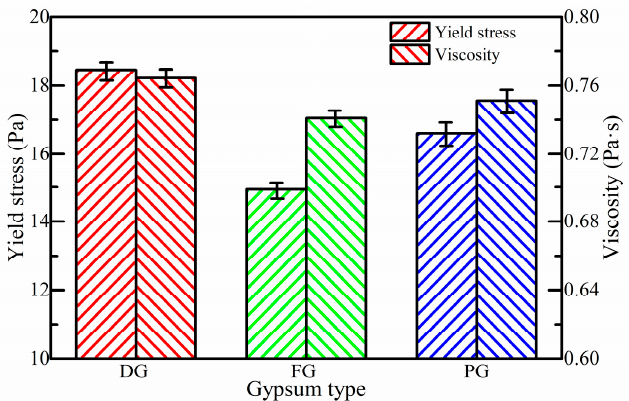
Figure 5. Yield stress and viscosity for fresh SSB-CPB with di ff erent gypsums.